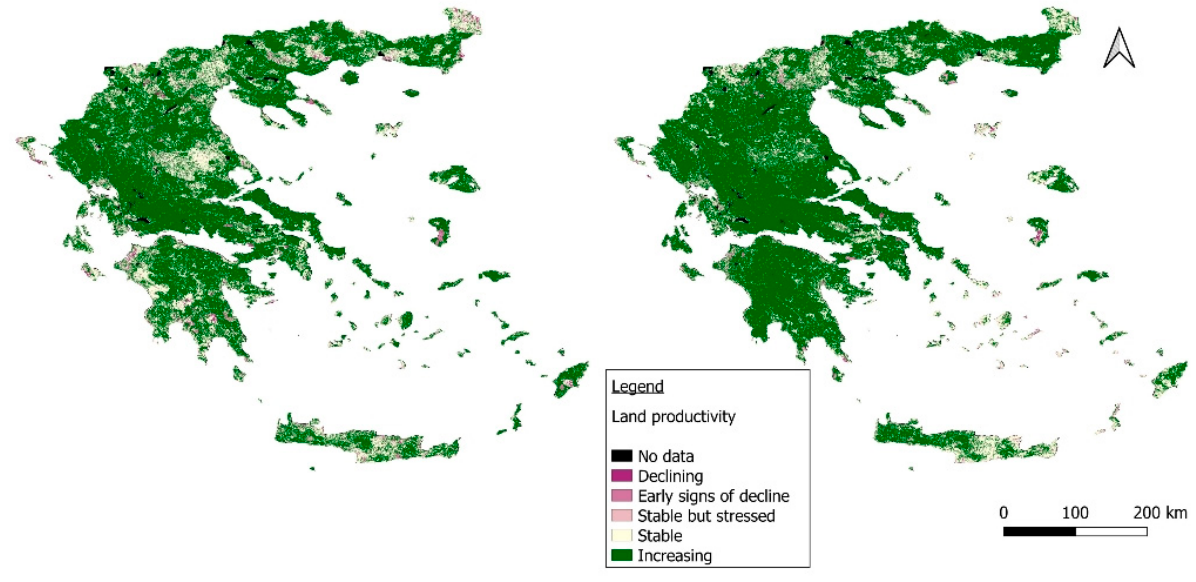
Figure 4. Spatial distribution of land productivity in Greece during the baseline period ( left ) and the reporting period ( right ).